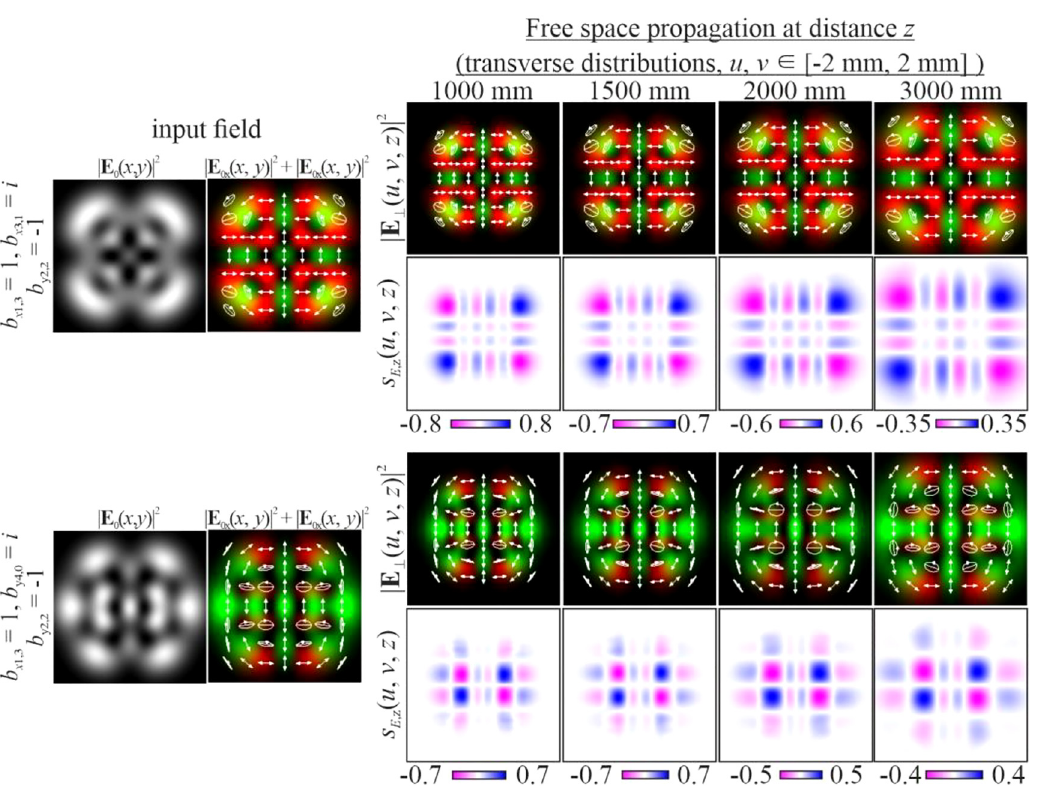
Figure 7: Propagationof nonuniformly polarized multimode HG beams defined by Eq. (11) with indices satisfying the condition de fi ned by Eq. (12) (nonuniformly polarized vector modes).